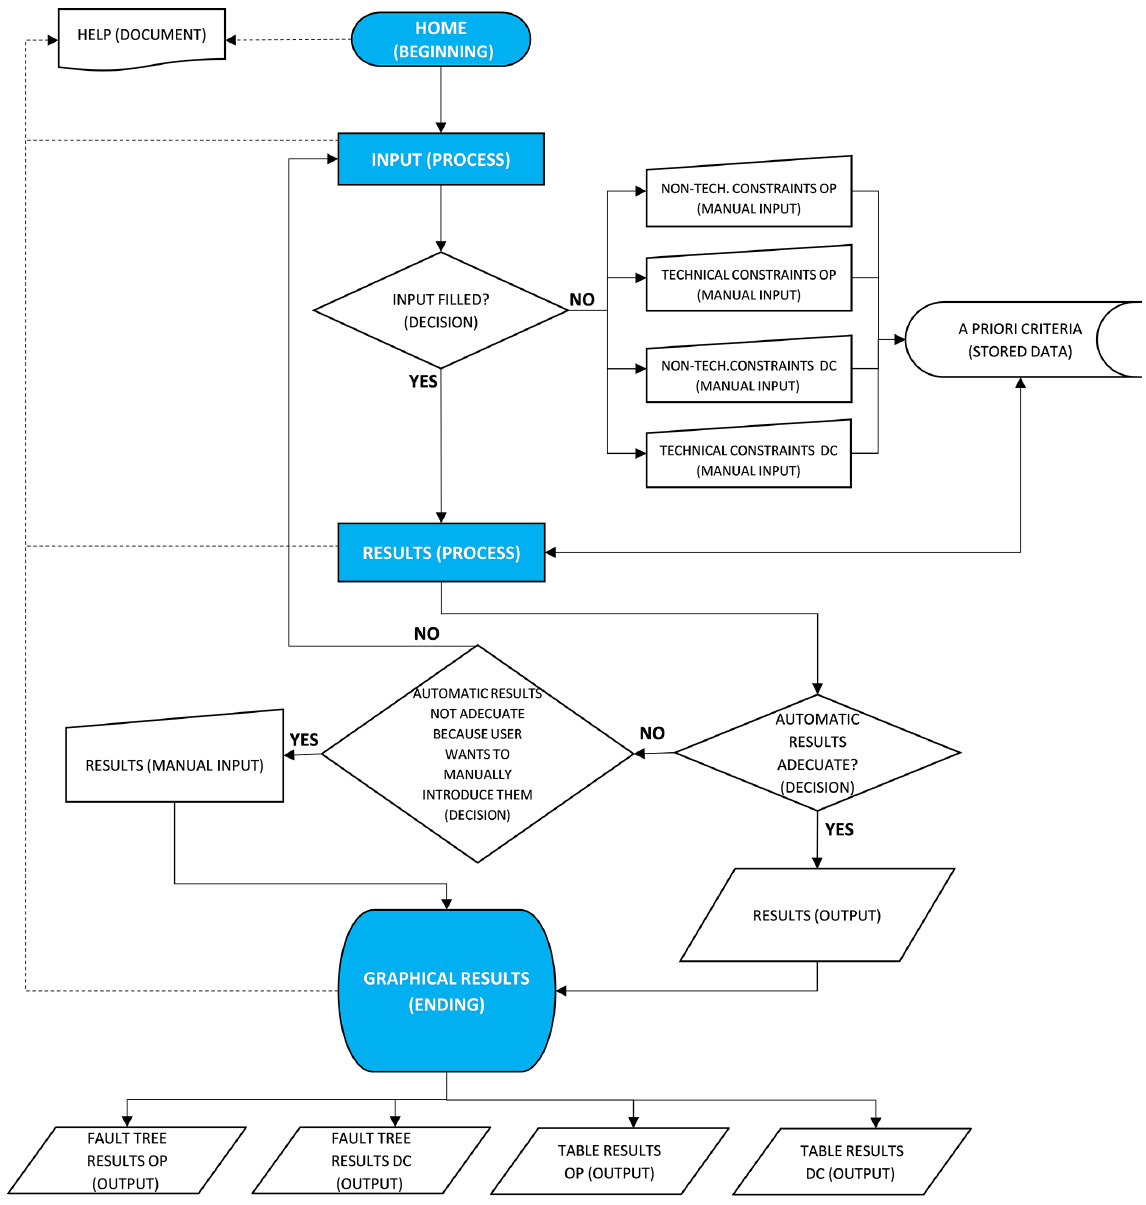
Figure 4. Flowchart for the main program of the